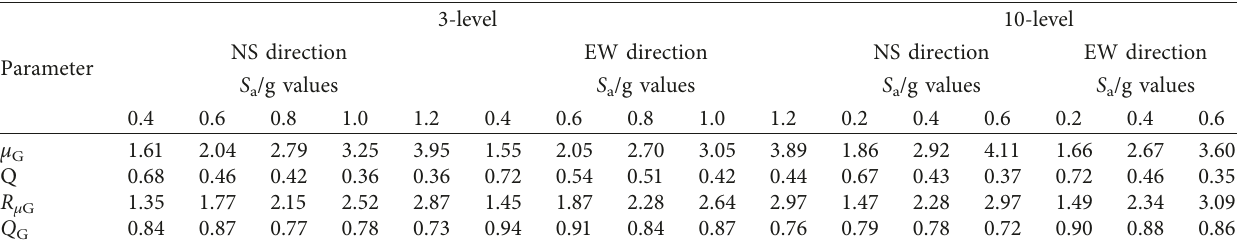
Figure 4: 10-level building. Mean values of µ S : (a) NS direction; (b) EW direction. Mean values of R µ S : (c) NS direction; (d) EW direction. Table 5: Mean of µ G , Q , R µ G , and Q G parameters, 3- and 10-level